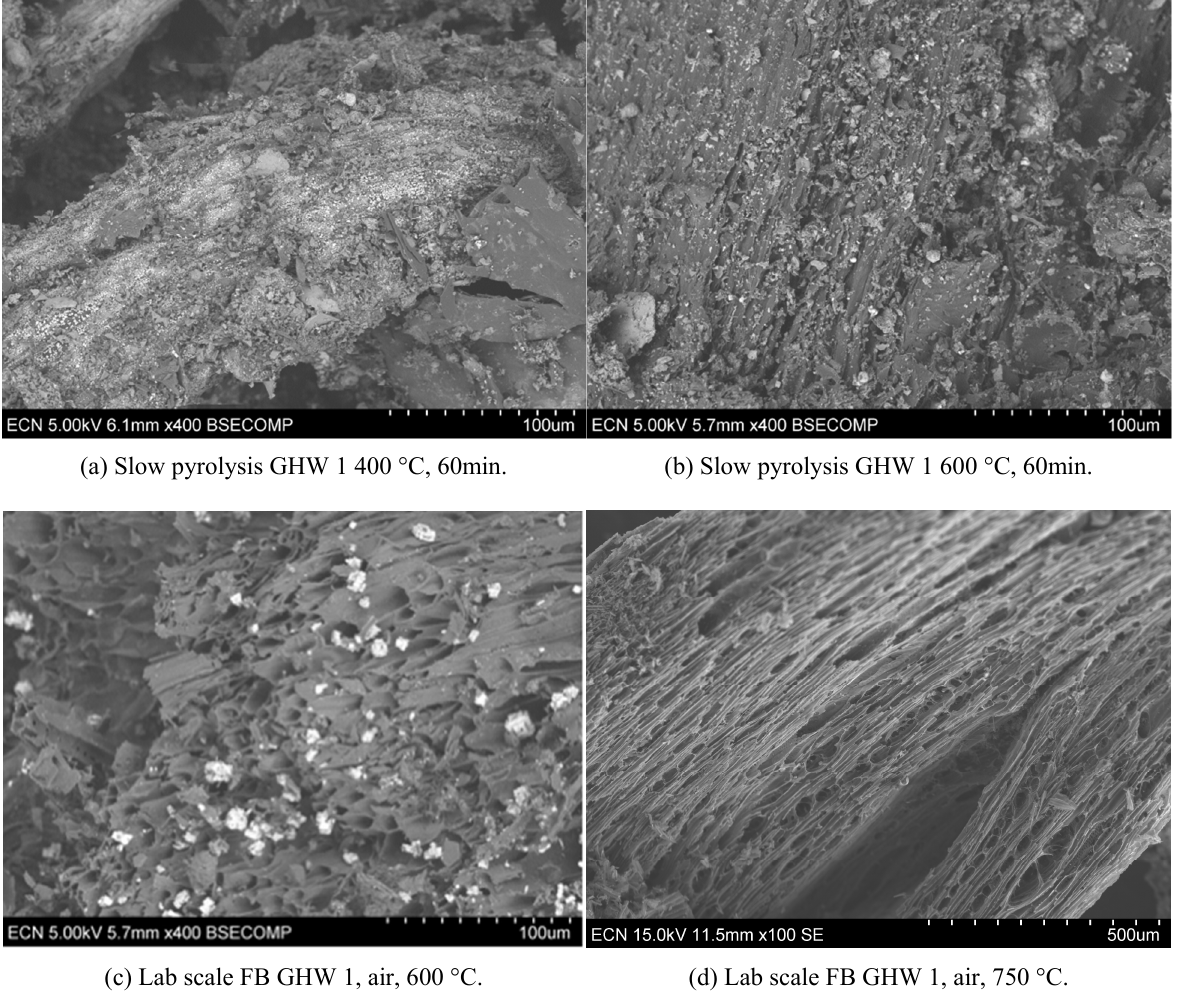
Figure 10. SEM pictures of greenhouse waste (pepper) biochar under pyrolysis ( a , b )